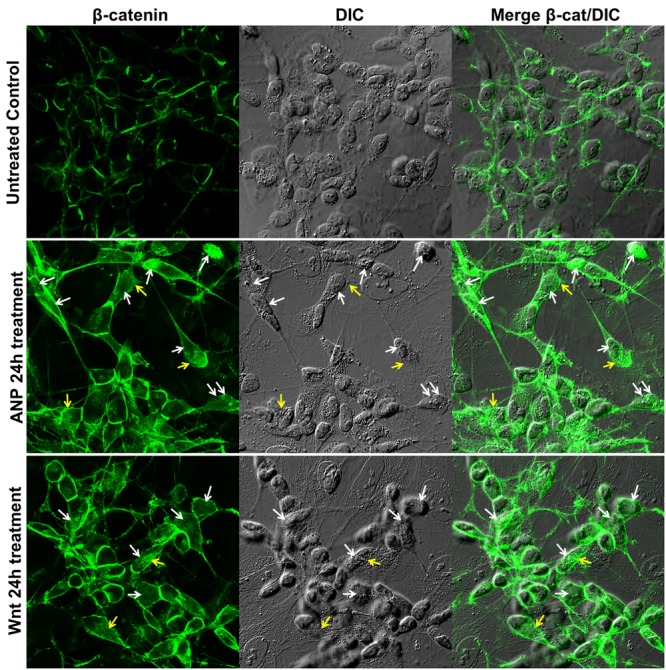
Atrial natriuretic peptide induces β-catenin stabilization and nuclear translocation in SHSY5Ydiff cells. Confocal microscopic images showing the intracellular distribution of β-catenin (green hue) in untreated control and in ANP or Wnt1a treated cells after 24 h of culture. Cell morphology was visualized by differential interference contrast (DIC), and merged images β-catenin/DIC are also shown. White and yellow arrows point to nuclear or cytoplasmic accumulation of β-catenin, respectively. Bar: 25 μm.